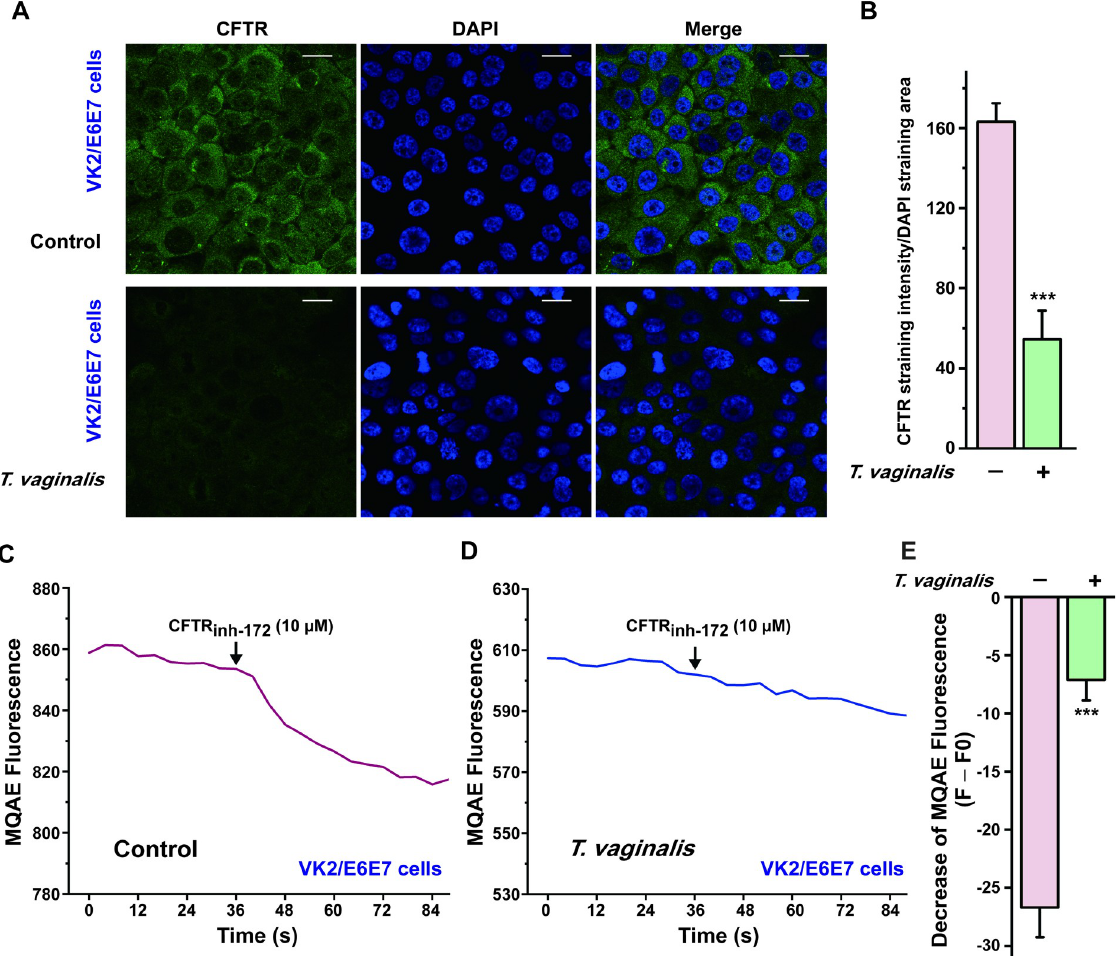
Fig 4. Trichomonas vaginalis infection induced down-regulation of cystic fibrosis transmembrane conductance regulator (CFTR) in human vaginal epithelial VK2/E6E7 cells. (A) Immunofluorescence images showing the expression of CFTR in VK2/E6E7 cells, in the absence or presence of 2 × 10 5 T . vaginalis infection for 3 h, with (B) the corresponding quantification analysis ( n = 3, ��� P < 0.001 versus the non-infected group). Scale bar = 20 μ m. (C) Representative trace showing the change of MQAE fluorescence elicited by CFTR inh-172 (10 μ M) in VK2/E6E7 cells. (D) Representative trace showing the change of MQAE fluorescence elicited by CFTR inh-172 (10 μ M) after 2 × 10 5 T . vaginalis infection for 3 h. (E) Statistical analysis showing the change of MQAE fluorescence intensity elicited by CFTR inh-172 (10 μ M), with or without T . vaginalis infection. Symbols and bars indicate the mean ± S.D. ( n = 39–41 cells for each group, ��� P < 0.001, versus the non- infected